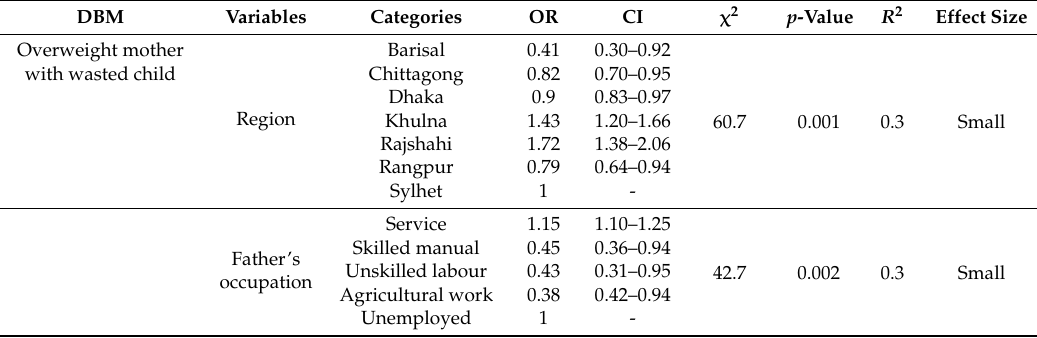
Table 6. Sequential multinomial logistic regression analysis of overweight mother and wasted child pairs by socio-demographic